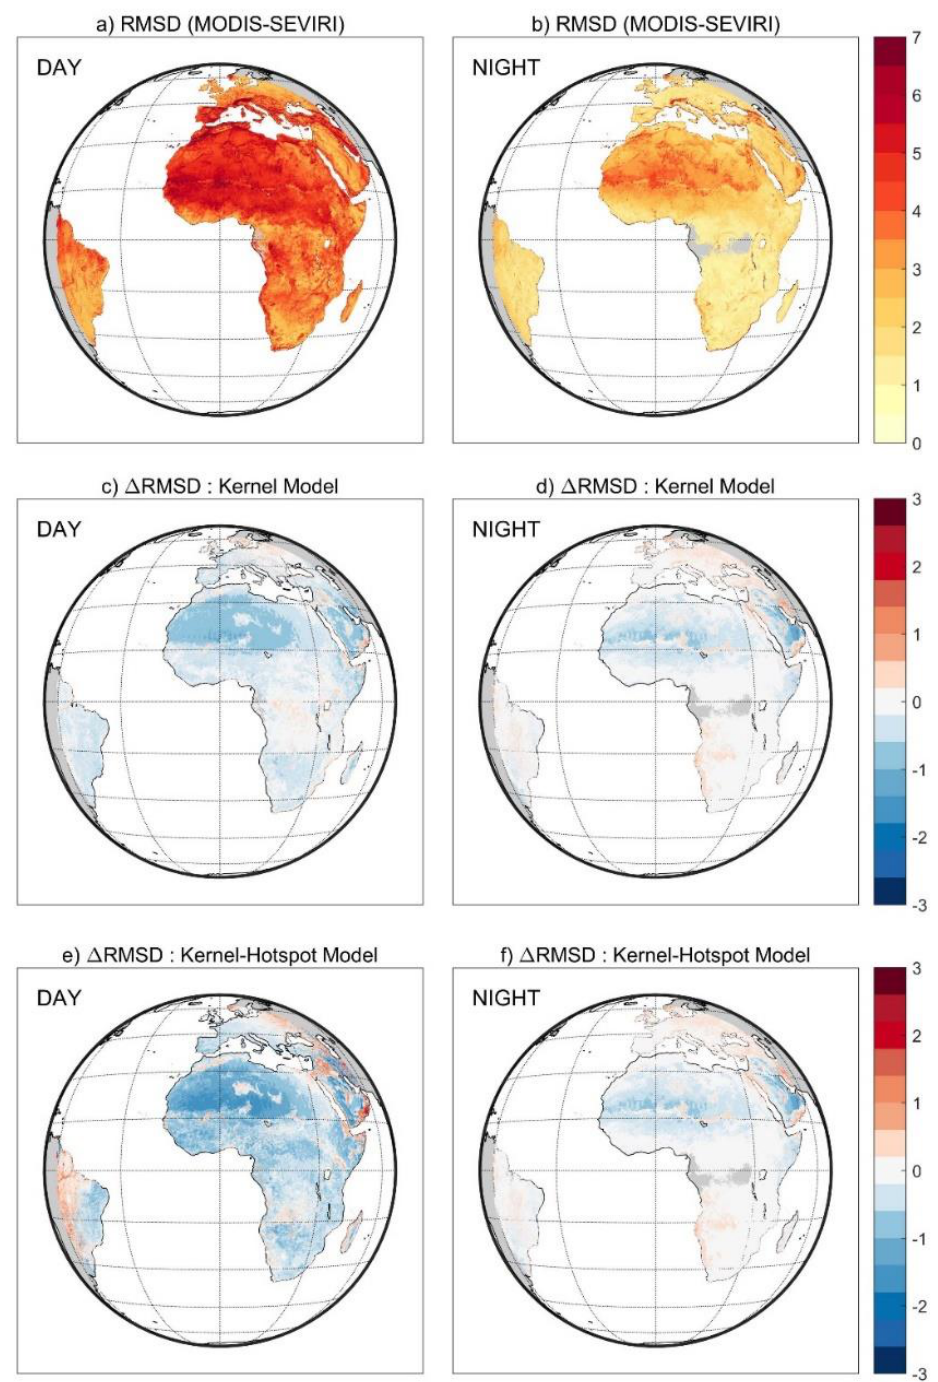
Figure 5. Spatial distribution of Root Mean Square Differences (RMSD) between SEVIRI and MODIS (K) without angular correction ( a , b ) and impact of LST angular correction on RMSD (in K; as (RMSD after angular correction)–(RMSD without correction)), as given by the Kernel model ( c , d ) and the Kernel-Hotspot model ( e , f ) when applied to data used in the calibration. The results are shown for daytime (left panels) and night-time (right panels) scenes, respectively.